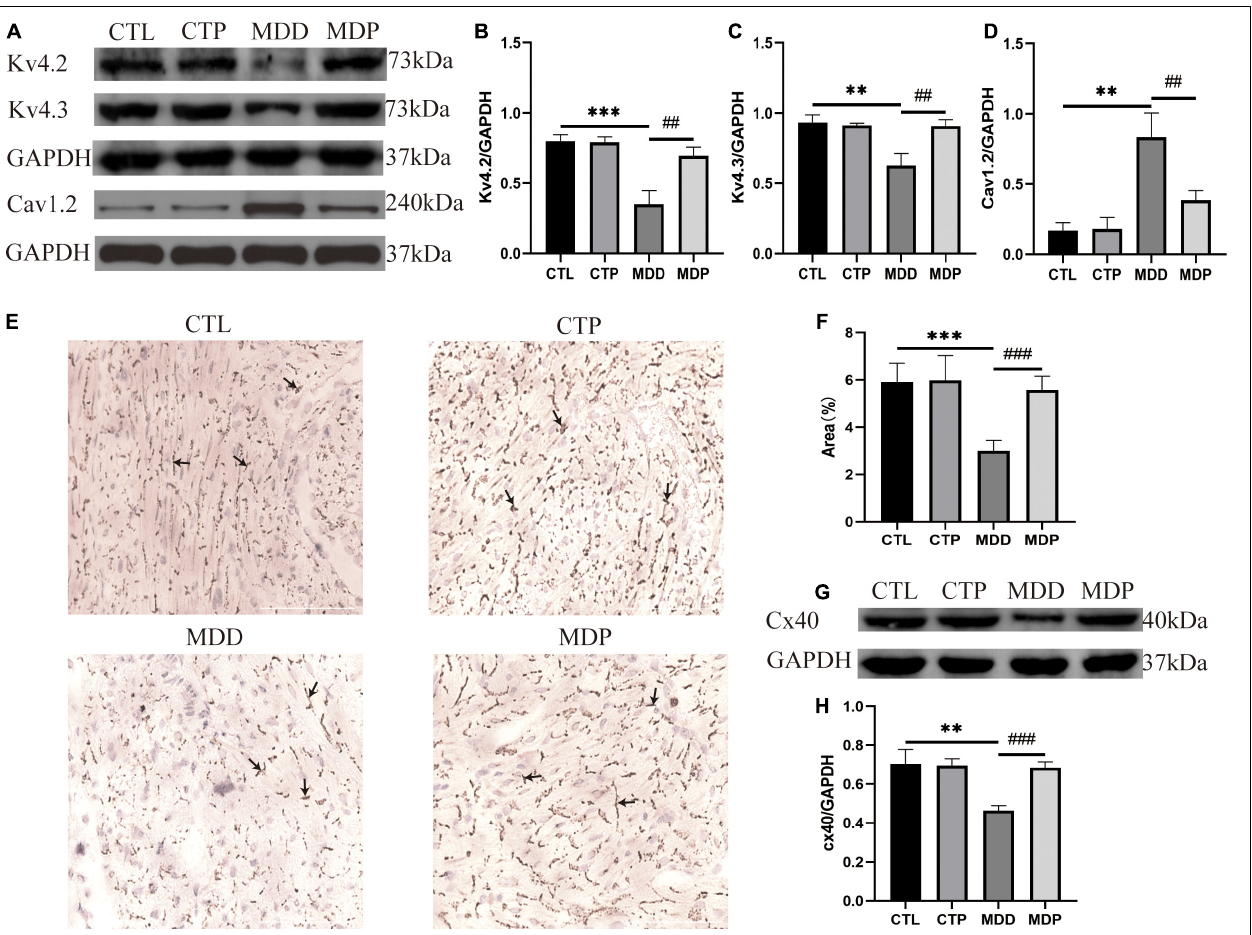
FIGURE 9 | The content of ion channels and Cx40. (A) Immunoblotting of Kv4.2, Kv4.3, and Cav1.2. (B–D) Quantitative analysis of Kv4.2, Kv4.3, and Cav1.2, n = 5 per group. (E) Typical images of Cx40 immunohistochemical staining. (F) Percentage of the cx40 area, n = 6 per group. (G) Immunoblotting of Cx40. (H) Quantitative analysis of Cx40, n = 5 per group. ** p < 0.01, *** p < 0.001 vs. CTL; ## p < 0.01, ### p < 0.001 vs.